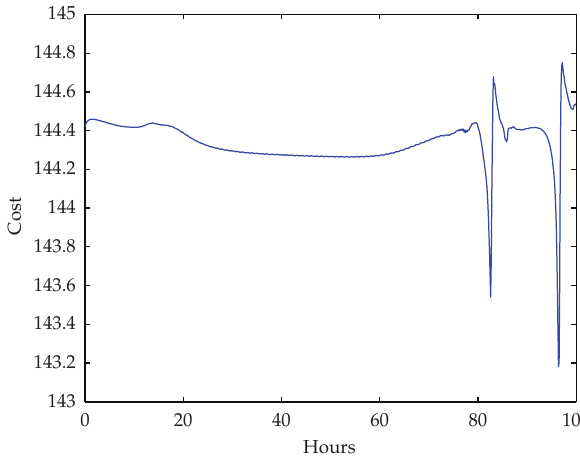
Figure 9: The optimal value of the cost of both the